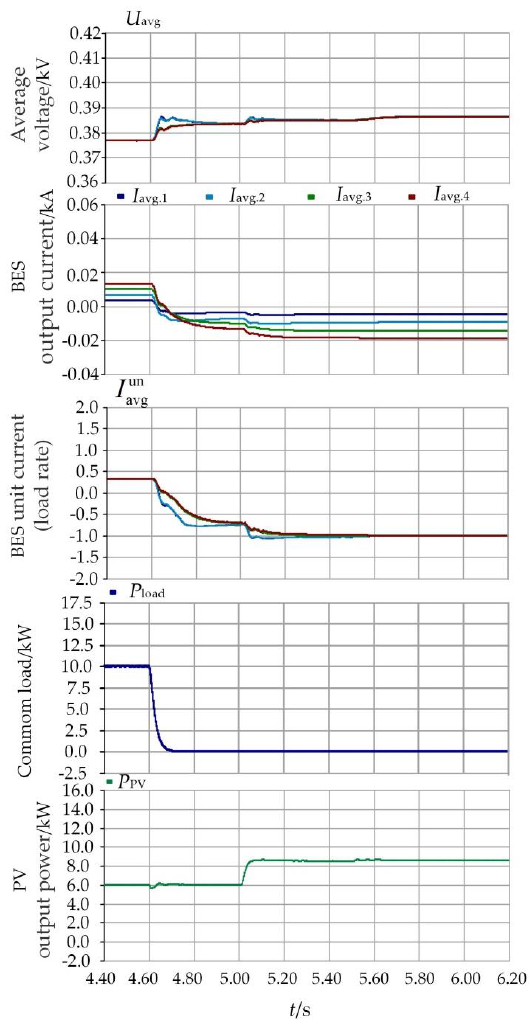
Figure 15. Simulation waveform of Situation